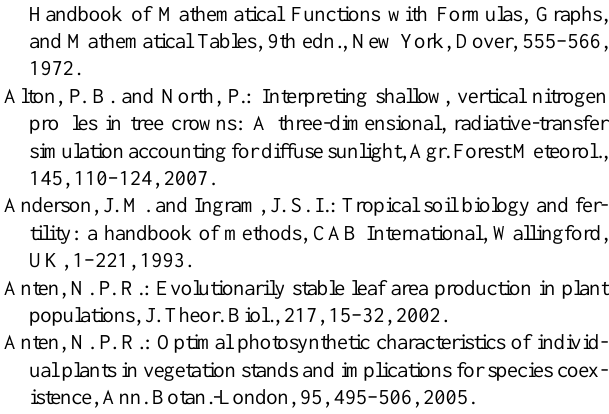
Fig. A1a and used for the paramaterisations of Eq. (A6). Nikos